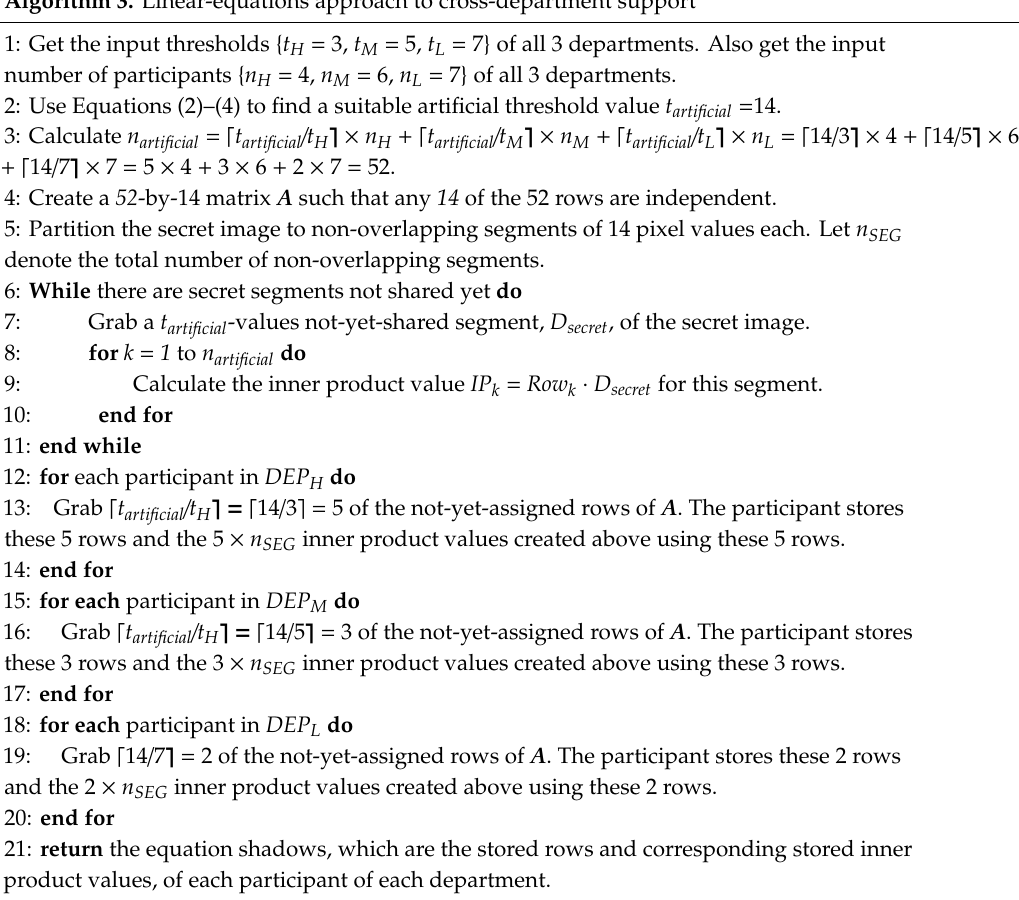
Algorithm 3. Linear-equations approach to cross-department